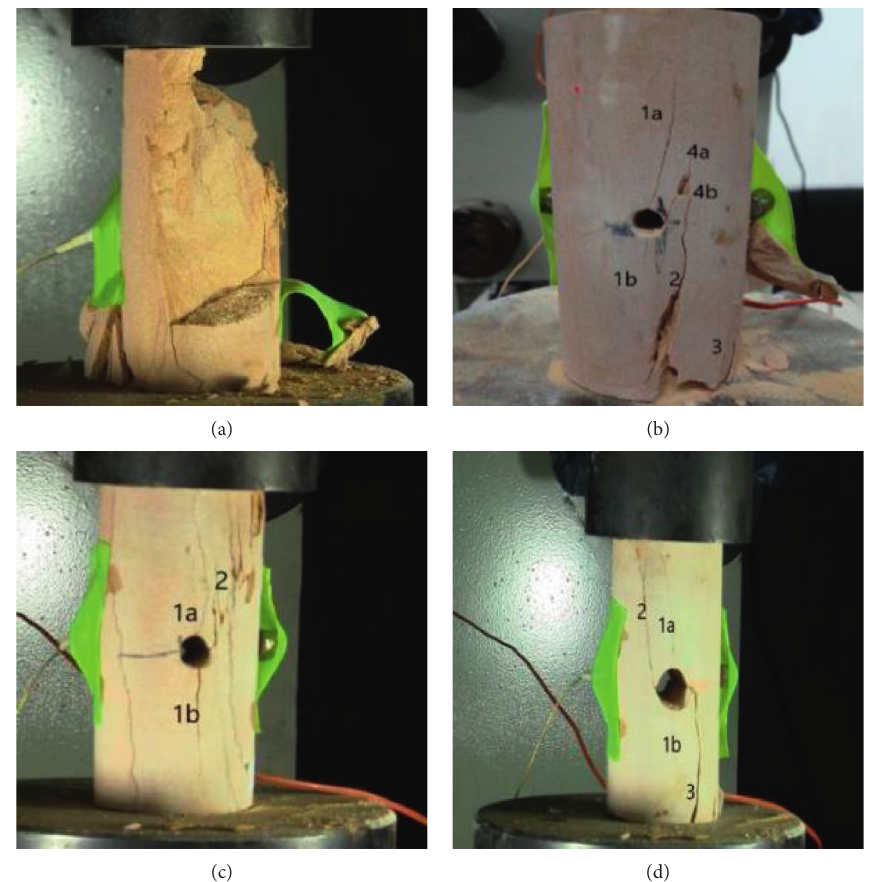
Figure 5: Failure patterns of the rock sample with different diameters of the horizontal hole. (a) Failure pattern of the intact rock sample. (b) Failure pattern of the rock sample with Φ 5 mm hole. (c) Failure pattern of the rock sample with Φ 10 mm hole. (d) Failure pattern of the rock sample with Φ 15 mm